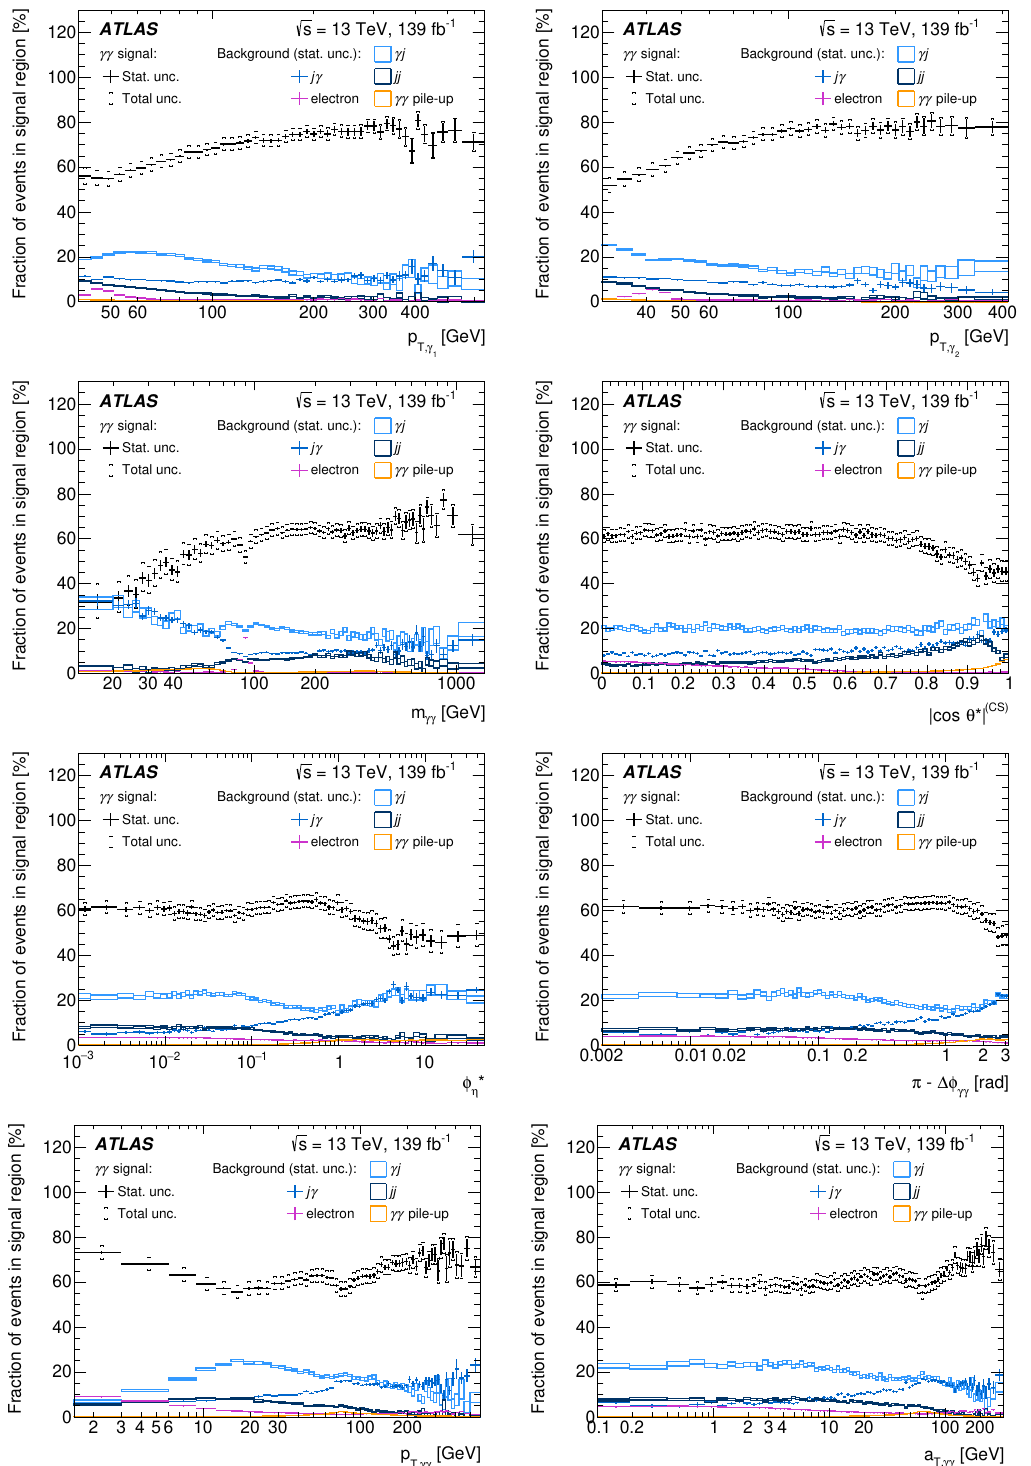
Figure 5. Sample decomposition as a function of each observable. For the γγ signal fraction, the total uncertainty is shown, while for the background fractions only the data and Monte Carlo statistical uncertainty component is